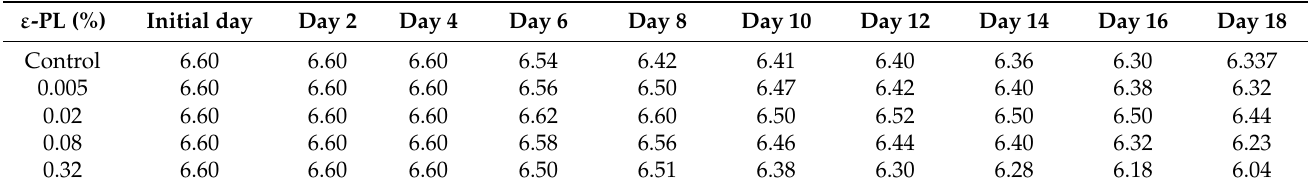
Table 2. pH monitoring of control milk sample and other milk samples added with various concen- trations of ε -PL.